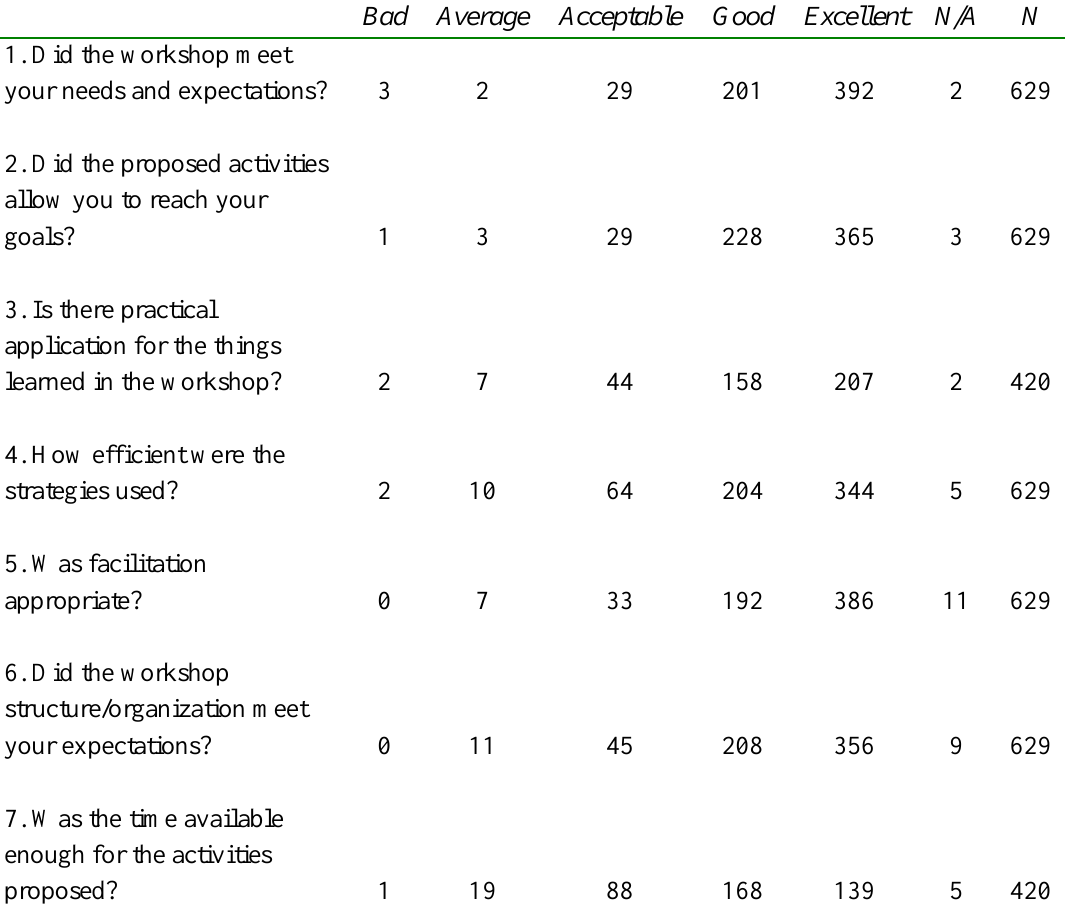
Summary of Answers Included in the EduCamp Survey Bad Average Acceptable Good Excellent N/A